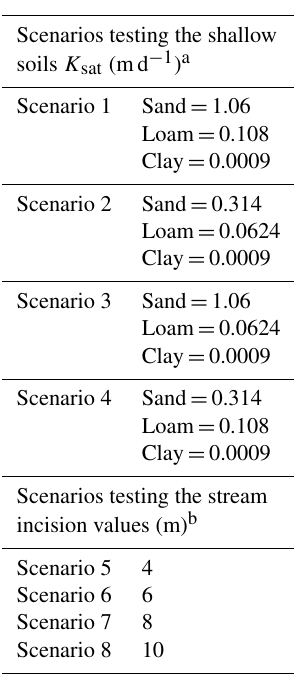
a For the corresponding unsaturated storage parameters, refer to Table 3. b Soil hydraulic properties for scenarios 5–8 are the same as those for scenario